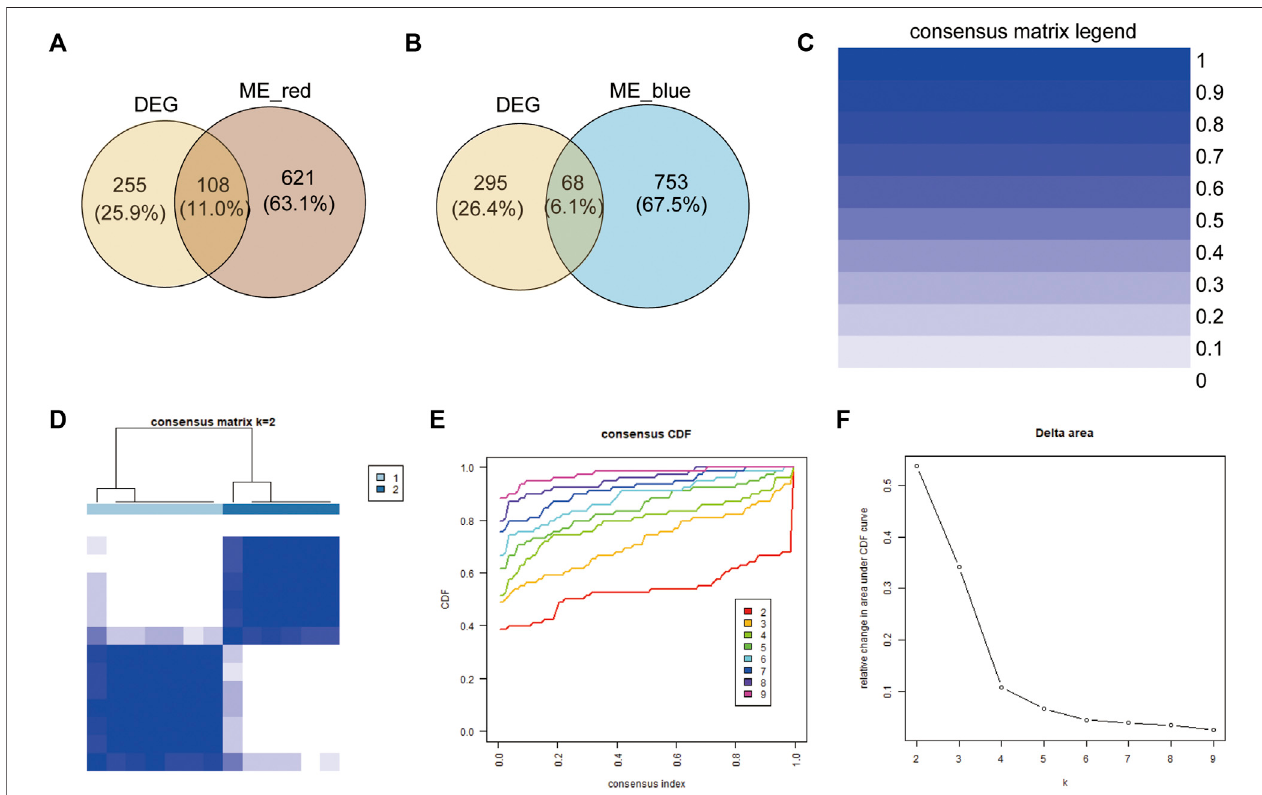
FIGURE3| Constructionofimmune-relatedgeneclusters. (A) Vennshowingtheco-genesbetweenredmodulegenesandDEGs. (B) Vennshowingtheco-genes between blue module genes and DEGs. (C) Consistency Unsupervised clustering color legend. (D) The consistency matrix of all data sets with k = 2. (E) Consistent cumulative distribution showing the cumulative distribution function with different values of k, which is used to judge the optimal value of k. (F) Delta area map.